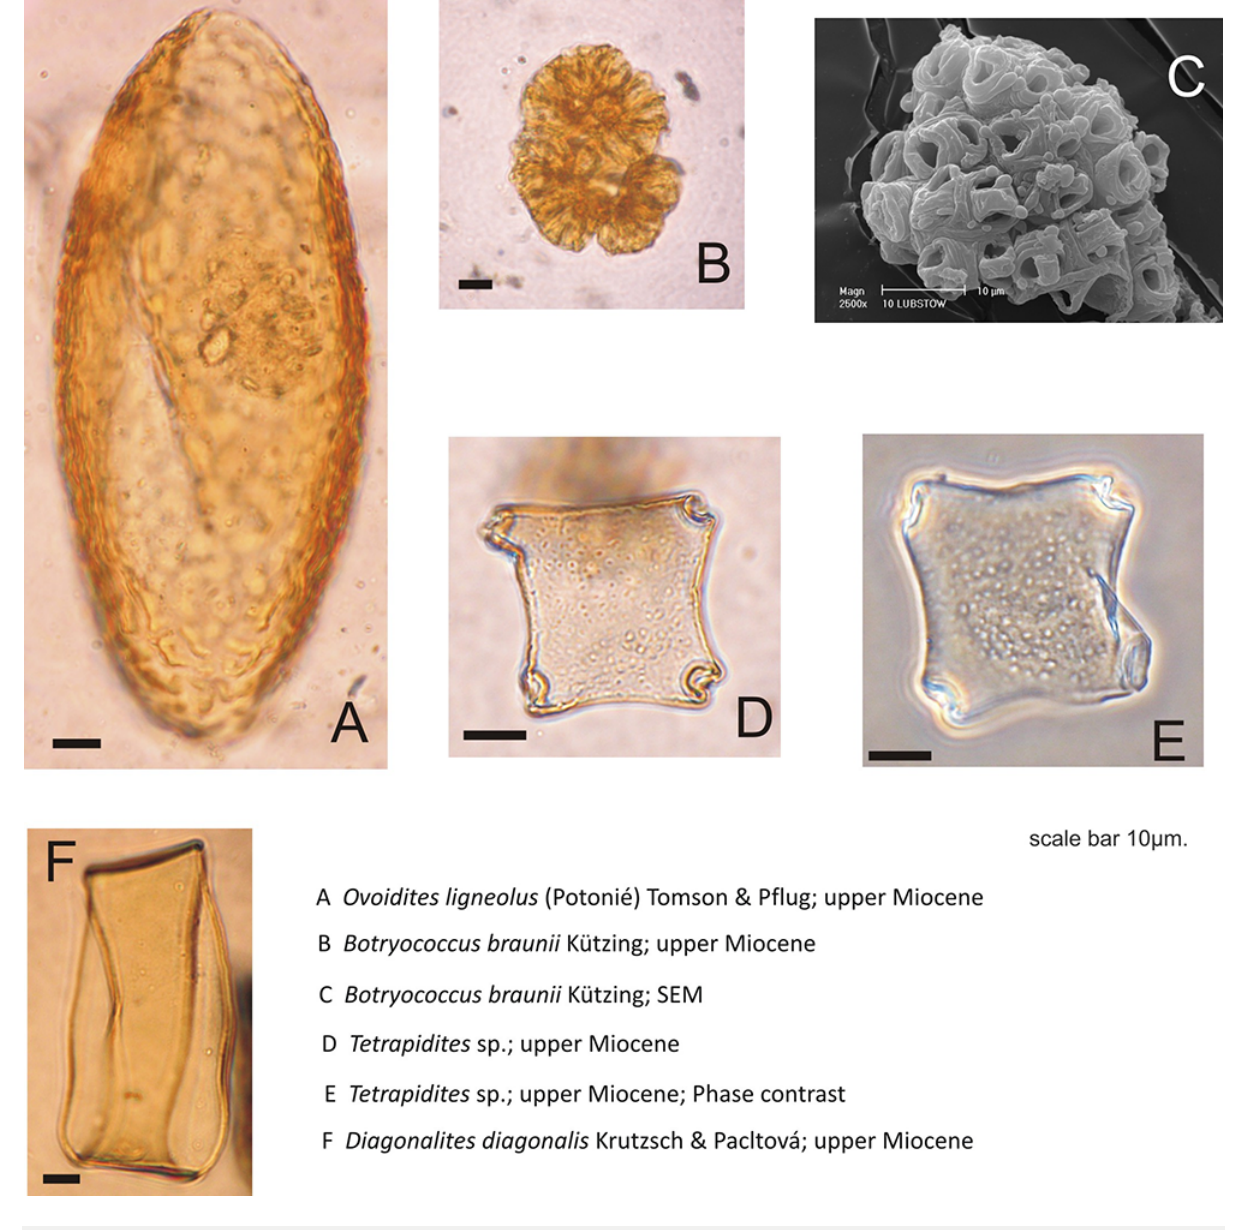
Figure 2 Freshwater microalgae (Chlorophyta) from Miocene deposits. Photo credits: Light microscopy (LM) – E. Worobiec; scanning electron microscopy (SEM) – M.